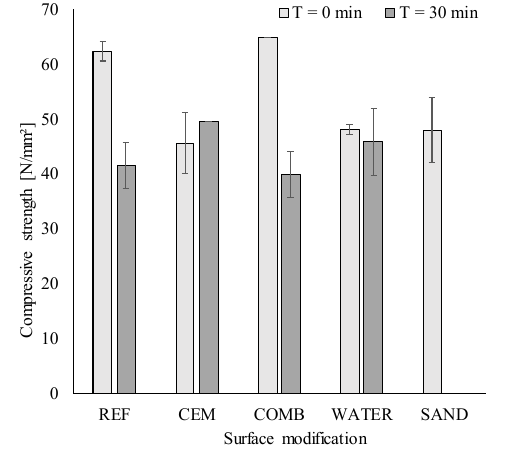
Figure 6. Compressive strength. Table 4. Compressive strength and strength